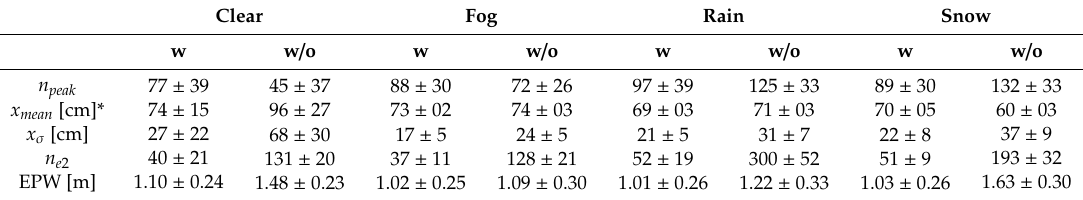
Table 4 . Most important parameters for the street region (33–37 m). (w/o) Without background radiation, (w) with background radiation. With 𝑛 (cid:3043)(cid:3032)(cid:3028)(cid:3038) : number of detections in the maximum, 𝑥 (cid:3040)(cid:3032)(cid:3028)(cid:3041) : mean detection distance, 𝑥 (cid:3097) : standard deviation of the detection distance, 𝑛 (cid:3032)(cid:2870) : number of second echo detections and 𝐸𝑃𝑊 : echo-pulse width. The results show mean value ± standard deviation. Clear Fog Rain